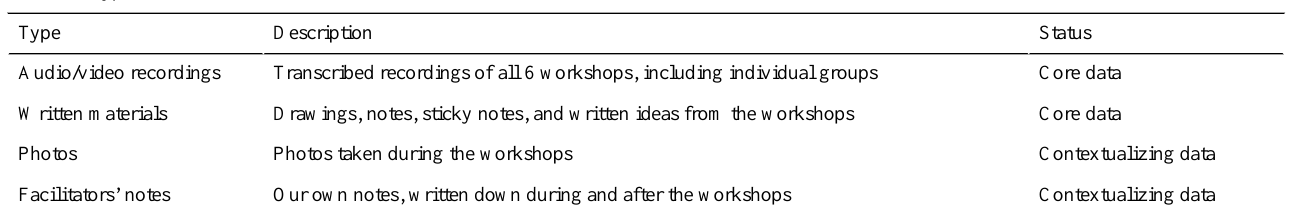
Table 2. Types of